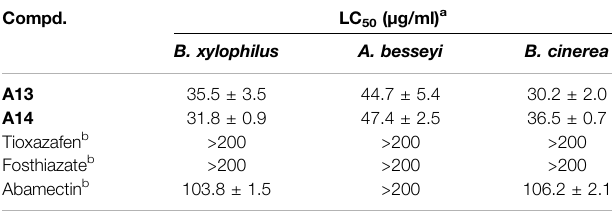
TABLE 3 | The LC 50 values of nematicidal activity of compounds.